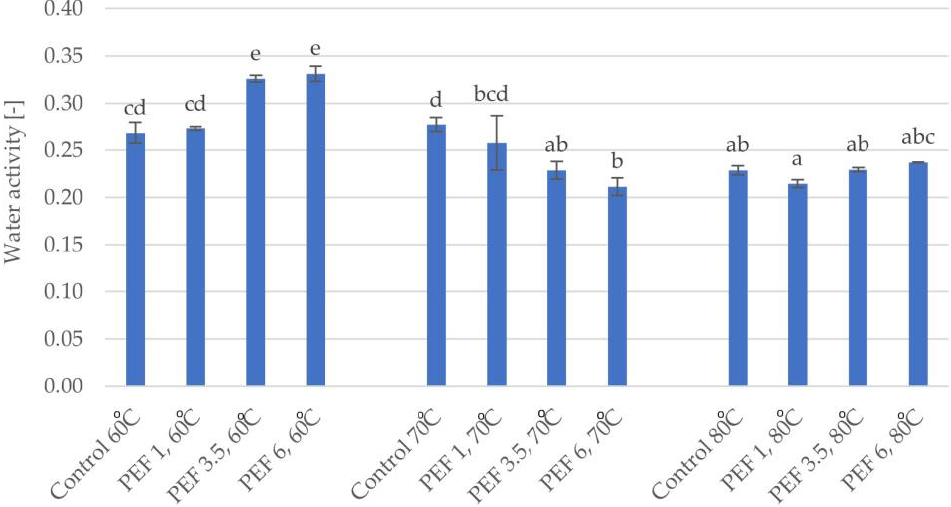
Figure 3. Water activity of dried apple tissue obtained using different values for the parameters of pulsed electric field intensity (1, 3.5, and 6 kJ/kg) and hot air drying temperature (60, 70, and 80 °C). The columns with different letters are significantly different ( p < 0.05).